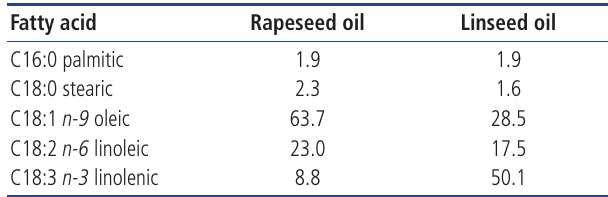
Table 2. Contents of some fatty acids in rapeseed and linseed oils (g FAME/100 g